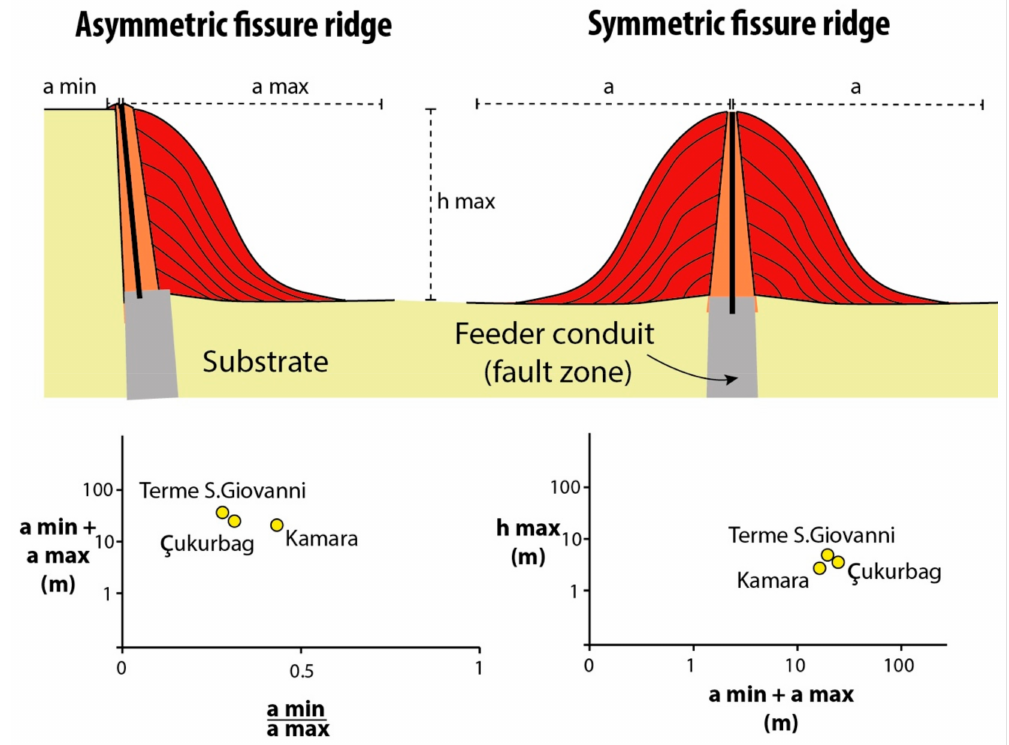
Figure 4. End-members of fissure-ridge-type travertine deposits and related diagrams.